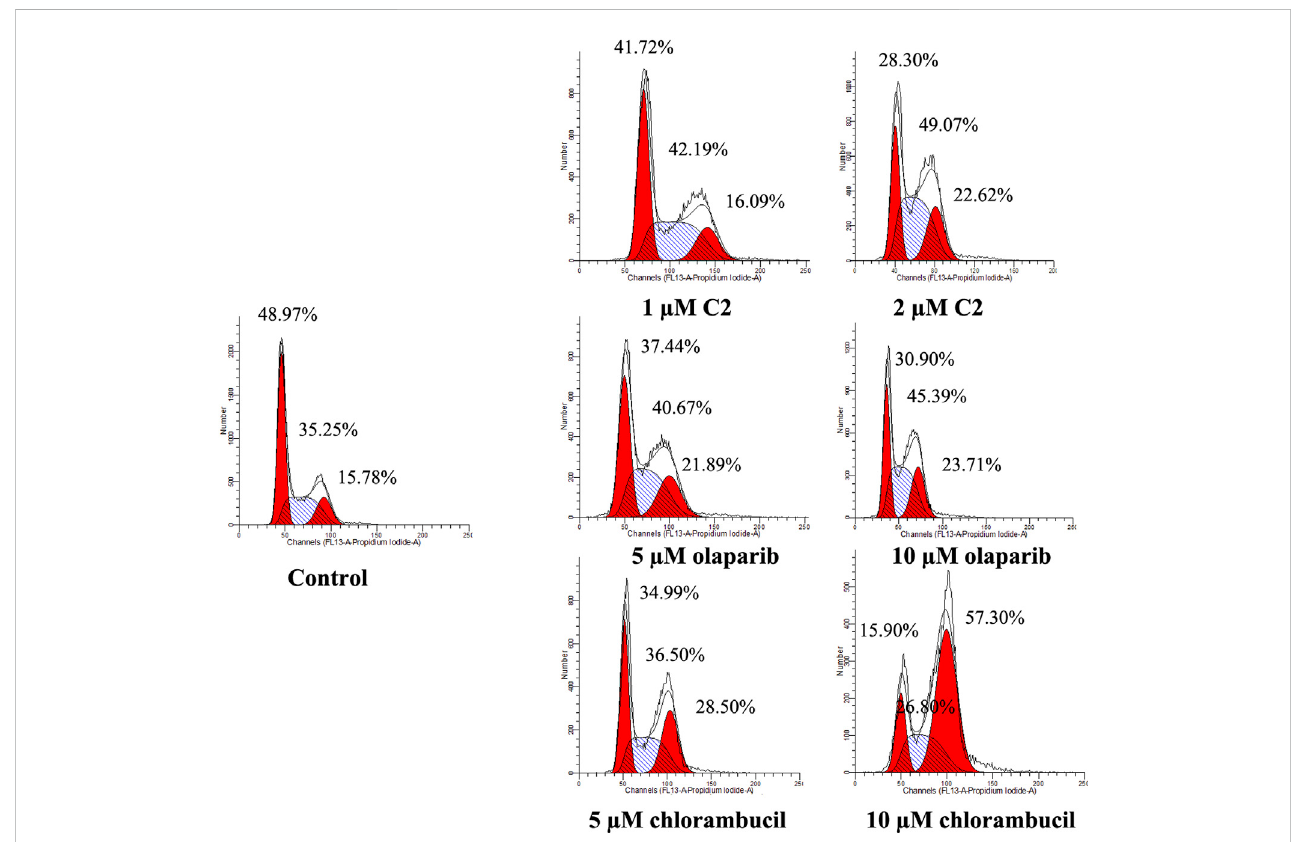
Cell cycle analysis of HCC1937 cells treated with molecule C2 , olaparib, or chlorambucil. Cells were treated with molecule C2 (1 or 2 µM), olaparib, or chlorambucil (5 or 10 µM) at different concentrations for 24 h. The results were evaluated using fl ow